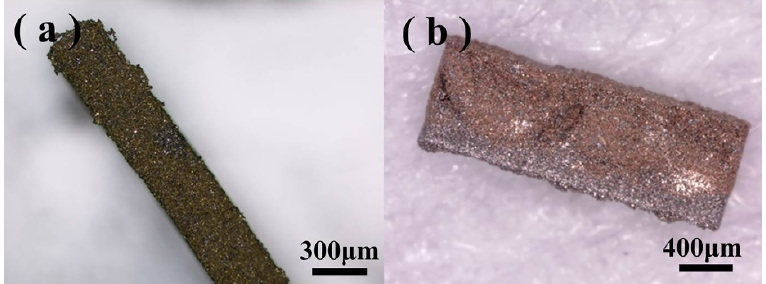
Figure 4. Sample after sintering of the 37 µm Cu powder mixed with 5 µm Sn powder in the through-trench. ( a ) Copper was observed to occupy most of the field on the upper surface and ( b ) a distinct stratification can be seen on the side.